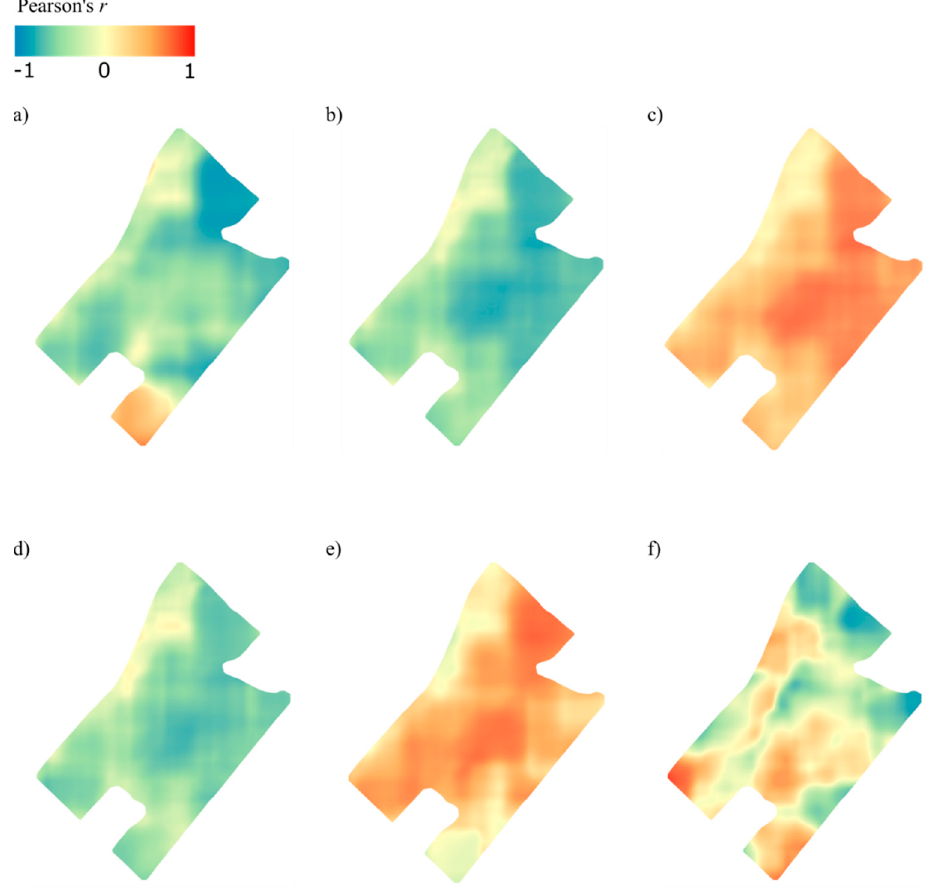
Figure 3. Correlation coefficients between study period average crop yield and ( a ) relative topographic position; ( b ) slope; ( c ) Wetness Index; ( d ) upslope flow path length; ( e ) Downslope Index; ( f ) CVA.